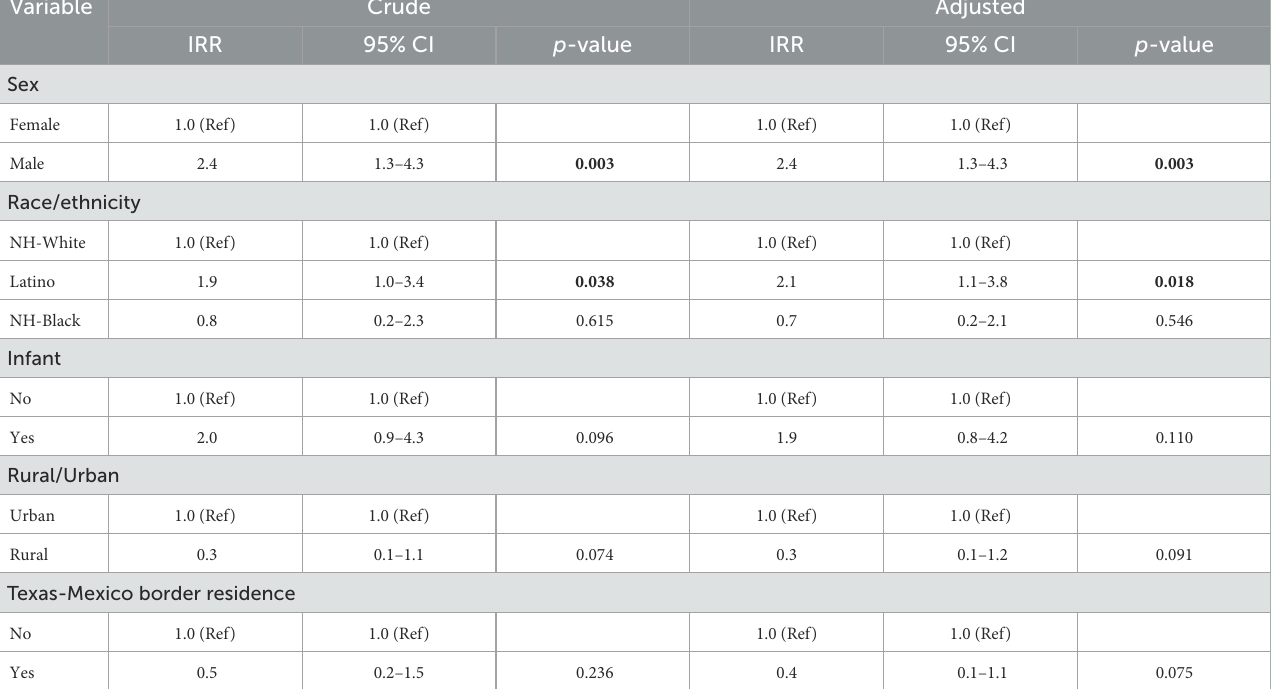
TABLE 3 Association between demographics characteristics and incidence of metastatic hepatoblastoma in Texas, 1995–2018. Variable